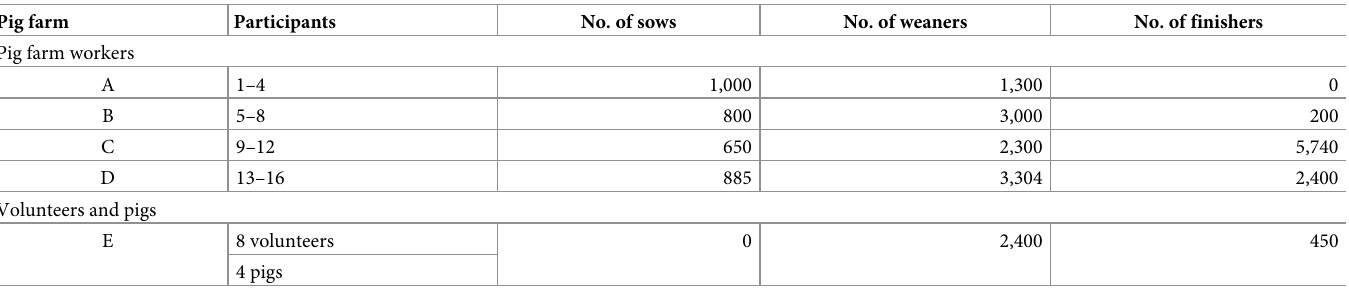
Table 1. Pig farms included in this